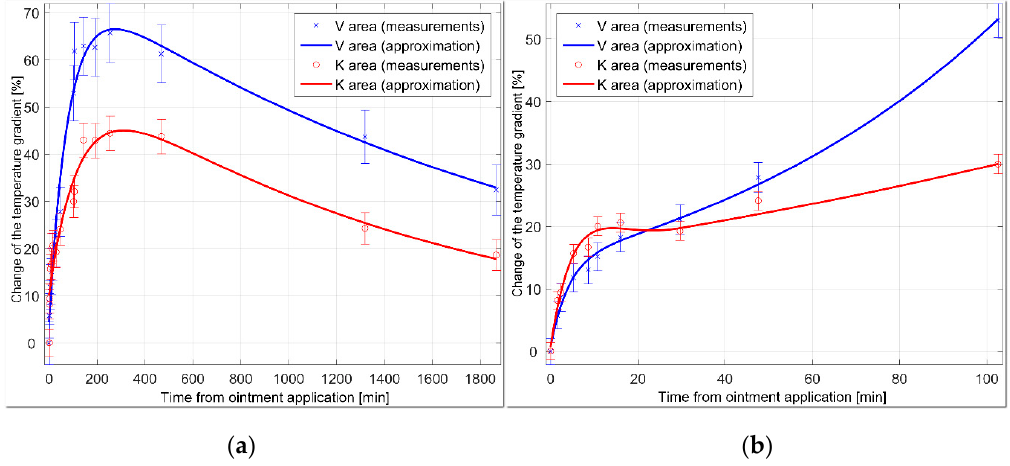
Figure 10. The development of the temperature gradient index in both areas during 31 h after the application of the ointments: ( a ) the overall progress of temperatures in both areas; ( b ) a detail of the first 100 min after the application of the drug [34].